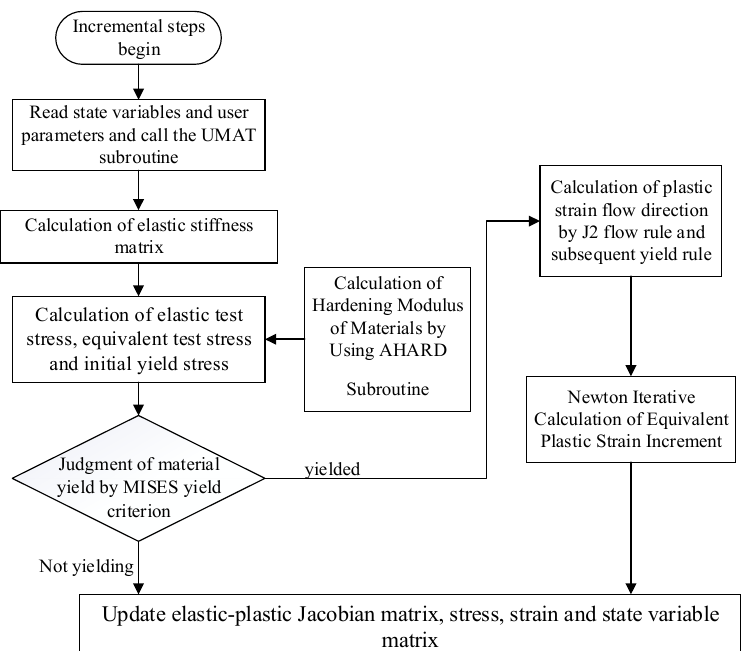
Figure 7. UMAT subroutine incremental step calculation flow chart.